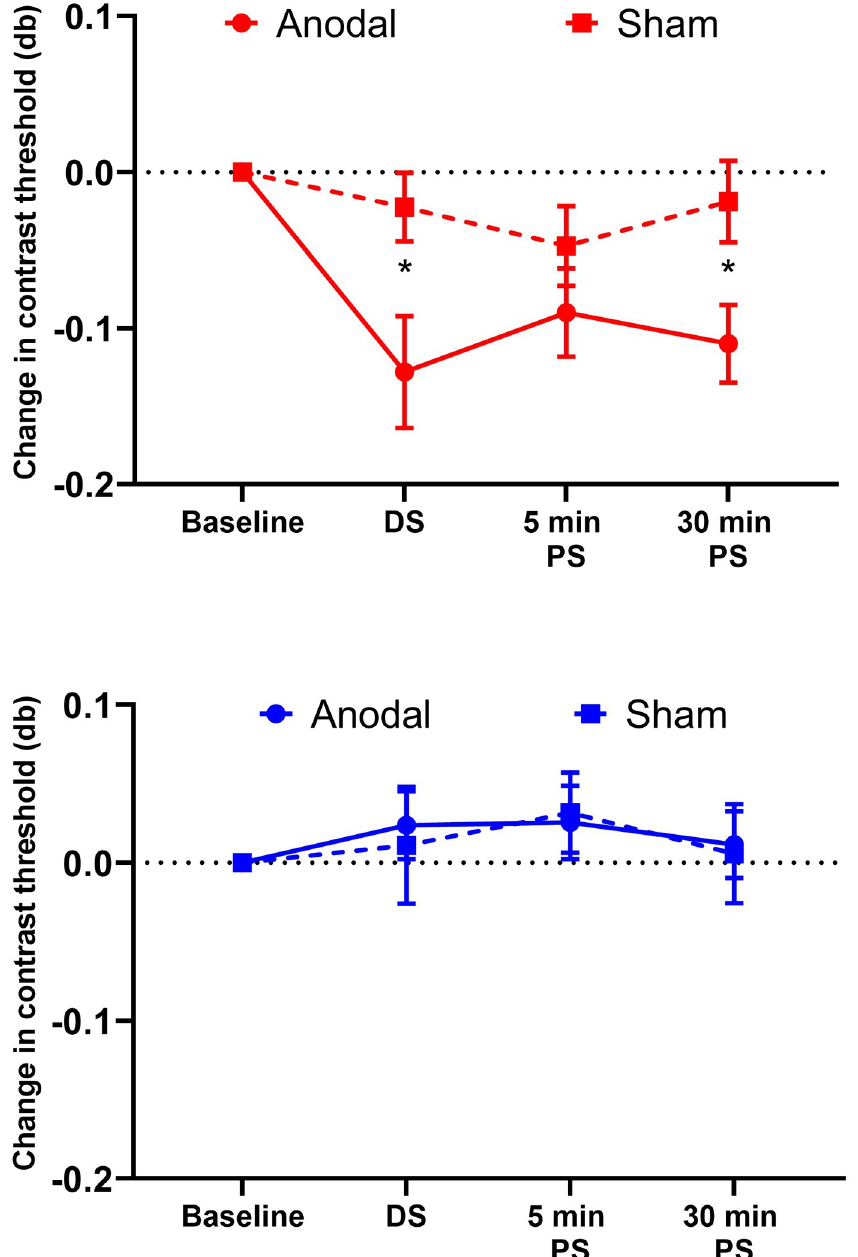
Fig 3. Reduction of collinear inhibition. Reduction of collinear inhibition using anodal-tDCS. Mean change in contrast detection threshold from baseline for the 2 λ (red) and 6 λ (blue) flanker separations for the anodal (solid line) and sham (dashed line) stimulation conditions. Error bars represent ± 1 SEM and asterisk symbols represent statistical significance (p < 0.05). DS, during stimulation; PS, post